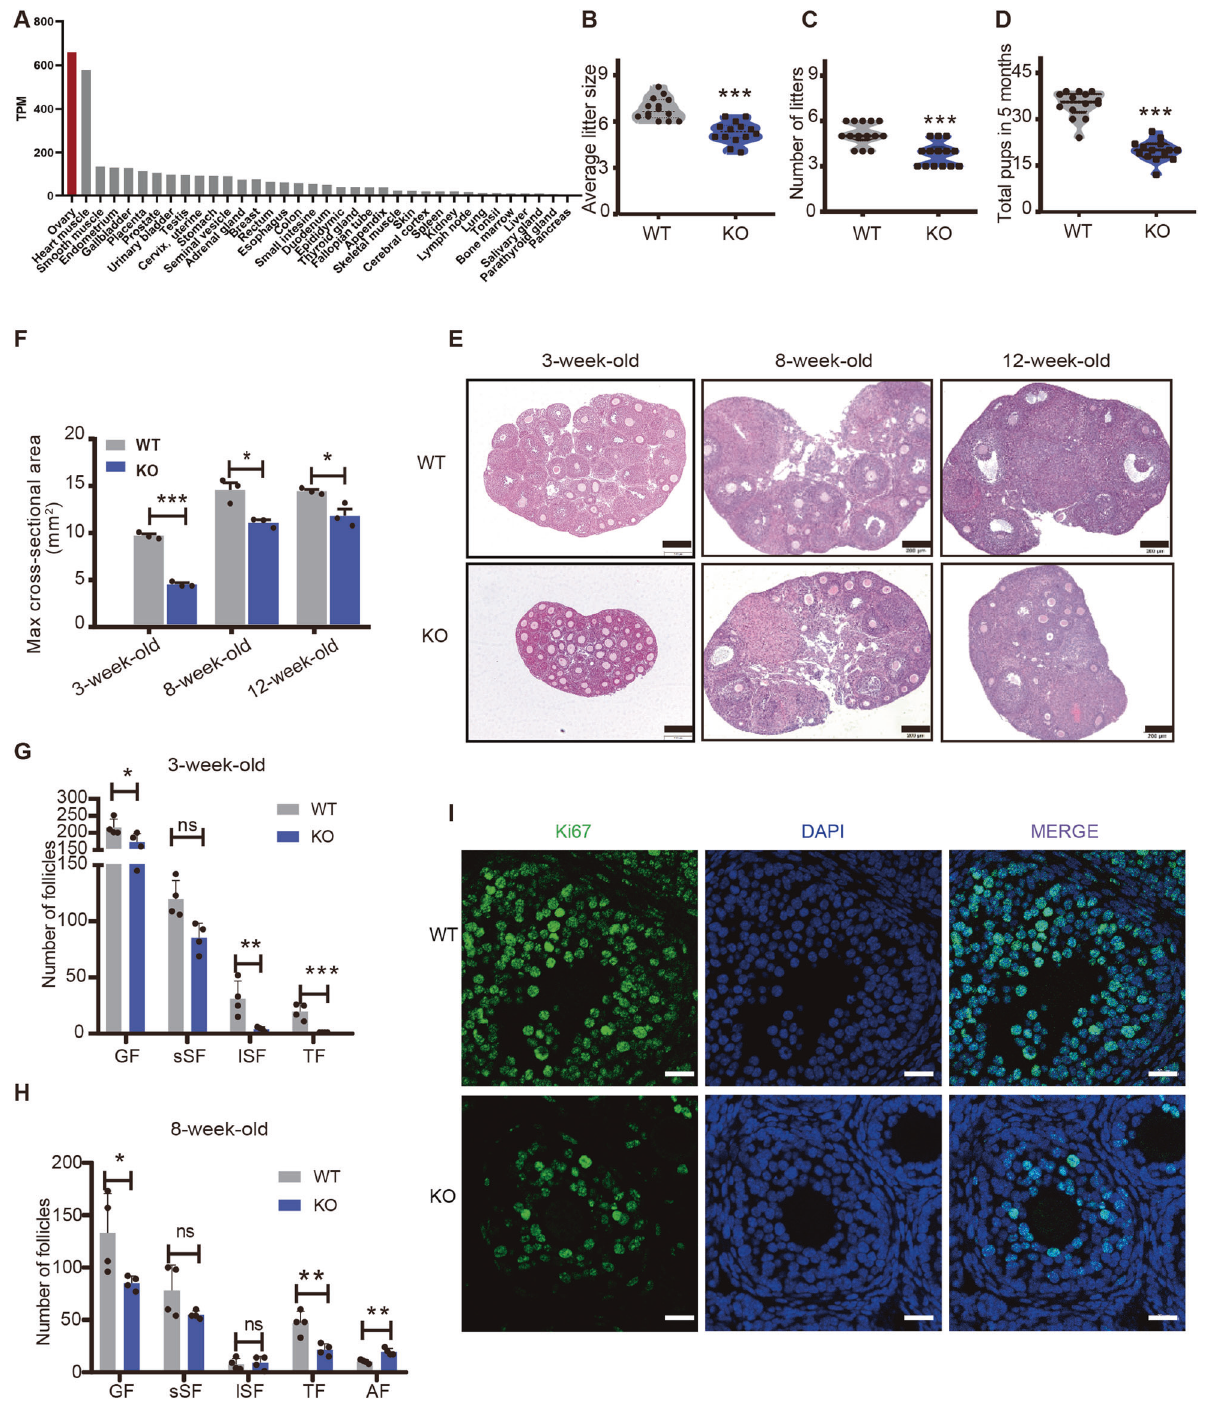
Fig. 1 The expression and localization of FHL2 in the ovarian follicles. A The protein expression pro fi les of FHL2 in human tissues. Data credit: Human Protein Atlas. Data summary image is derived from the human protein atlas database (ps://v18.proteinatlas.org/ ENSG00000115641-FHL2/tissue). B – D The Average litter size ( B ), the number of litters/female ( C ), and total pups ( D ) in wildtype (WT) and Fhl2 knockout (KO) mice during 5-months breeding trial. N = 14 for each group. E Hematoxylin and eosin (HE) staining of ovaries isolated from 3-week-old, 8-week-old, and 12-week-old of WT and Fhl2 KO mice. Scale bars: 200 μ m. F Max cross-sectional area of ovaries from 3-week-old, 8- week-old, and 12-week-old of WT and Fhl2 KO mice. N = 3 for each group. G , H Number of follicles per ovary isolated from 3-week-old WT or KO mice ( G ), and 8-week-old WT or KO mice ( H ). N = 4 for each group. GF total growing follicle, sSF small secondary follicle (wrapped up by 2 – 5 layers of granule cells), lSF large secondary follicles (wrapped up by more than 5 layers of granule cells), TF tertiary Follicles, AF atretic follicle. I Representative image of immuno fl uorescence staining of Ki67 in WT and Fhl2 KO mice ovaries. Green color indicated Ki67 immunosignal. Nuclei were staining with DAPI in blue. Scale bar: 20 µm. Student ’ s t test was used to compare the difference between groups. Data are shown as mean ± SEM. * P < 0.05, ** P < 0.01, *** P < 0.001. ns non-signi fi cant.